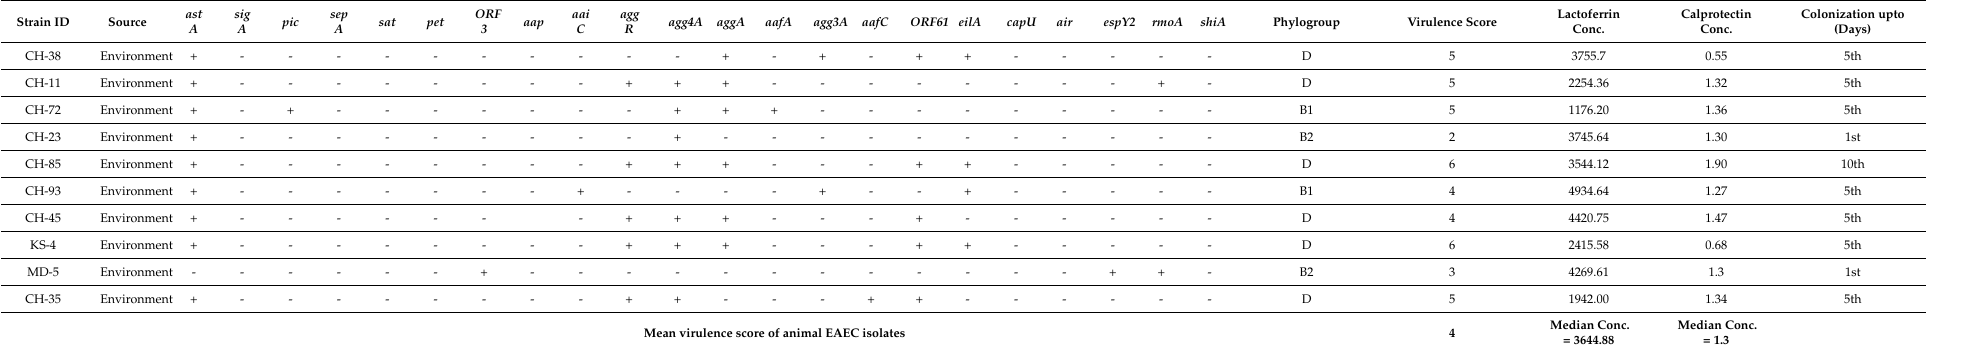
Table 4. The virulence genes’ content, phylogroups, inflammatory markers, and colonization from environment